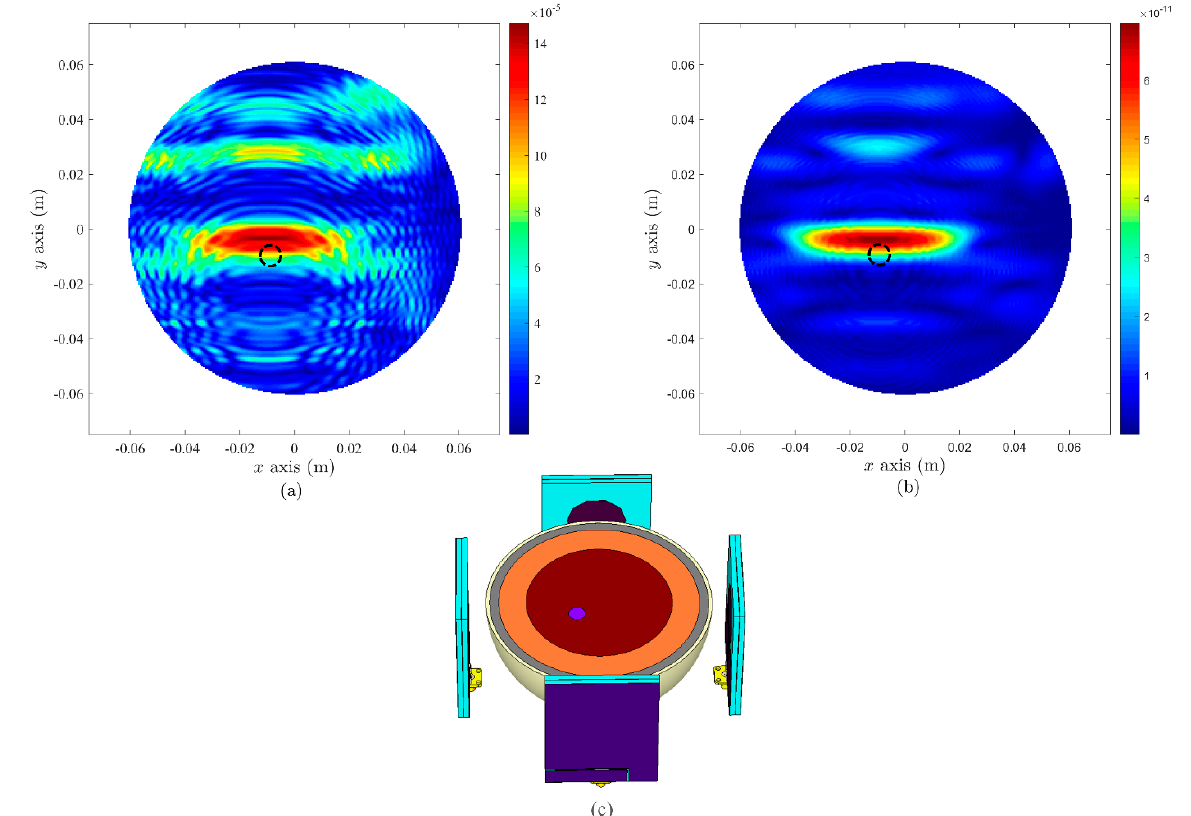
Figure 20. MWI results based on four antennas in simulation: ( a ) DAS, ( b ) DMAS algorithms, and ( c ) depiction of simulated setup.